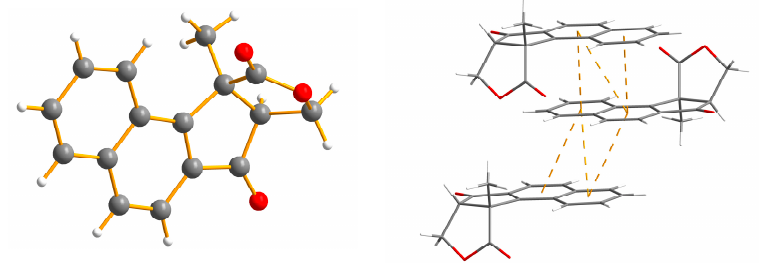
Figure 4. X-ray structure of tetracyclic lactone 16 [24].